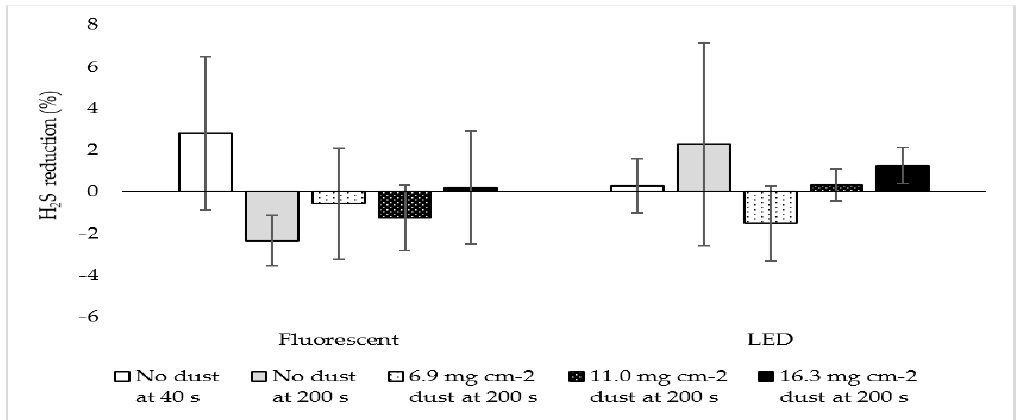
Figure 7. H 2 S mitigation under different poultry dust levels at 12% of relative humidity in photocatalysis. Error bars signify ± standard deviation.